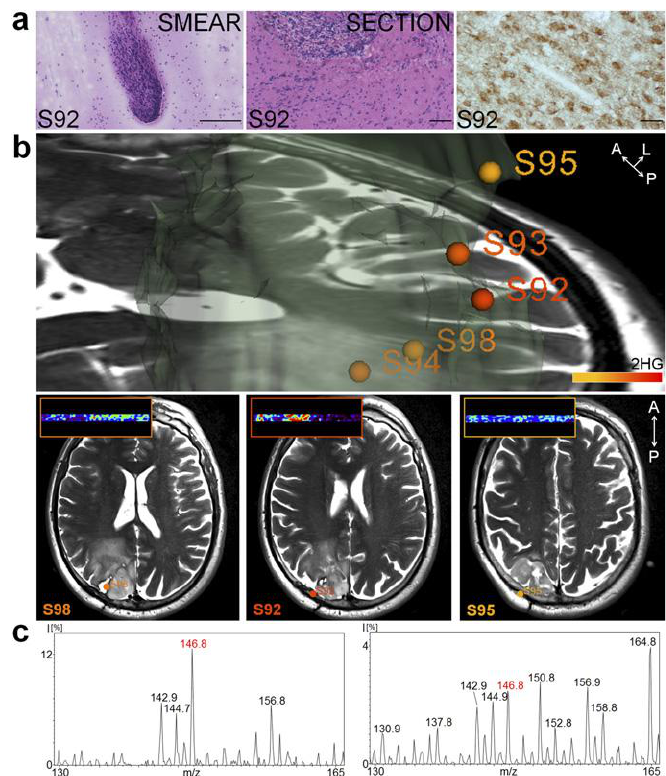
Figure 3. Intraoperative mass spectrometry of an onco-metabolite to guide brain tumor resection. ( a ) H & E-stained smear ( Left ), frozen tissue section ( Center ), and immunohistochemistry using an IDH1 R132H point mutation-specific antibody in an oligoastrocytoma grade III samples; ( b ) 3D tumor volume representation showing normalized 2-hydroxyglutarate (2-HG) signal represented with a warm color scale (lowest (yellow) to highest (red)); ( c ) Negative ion mode DESI mass spectra obtained from a smear ( Left ) and a section from an oligoastrocytoma grade III ( Right ). Used with permission from Santagata et al. [82].